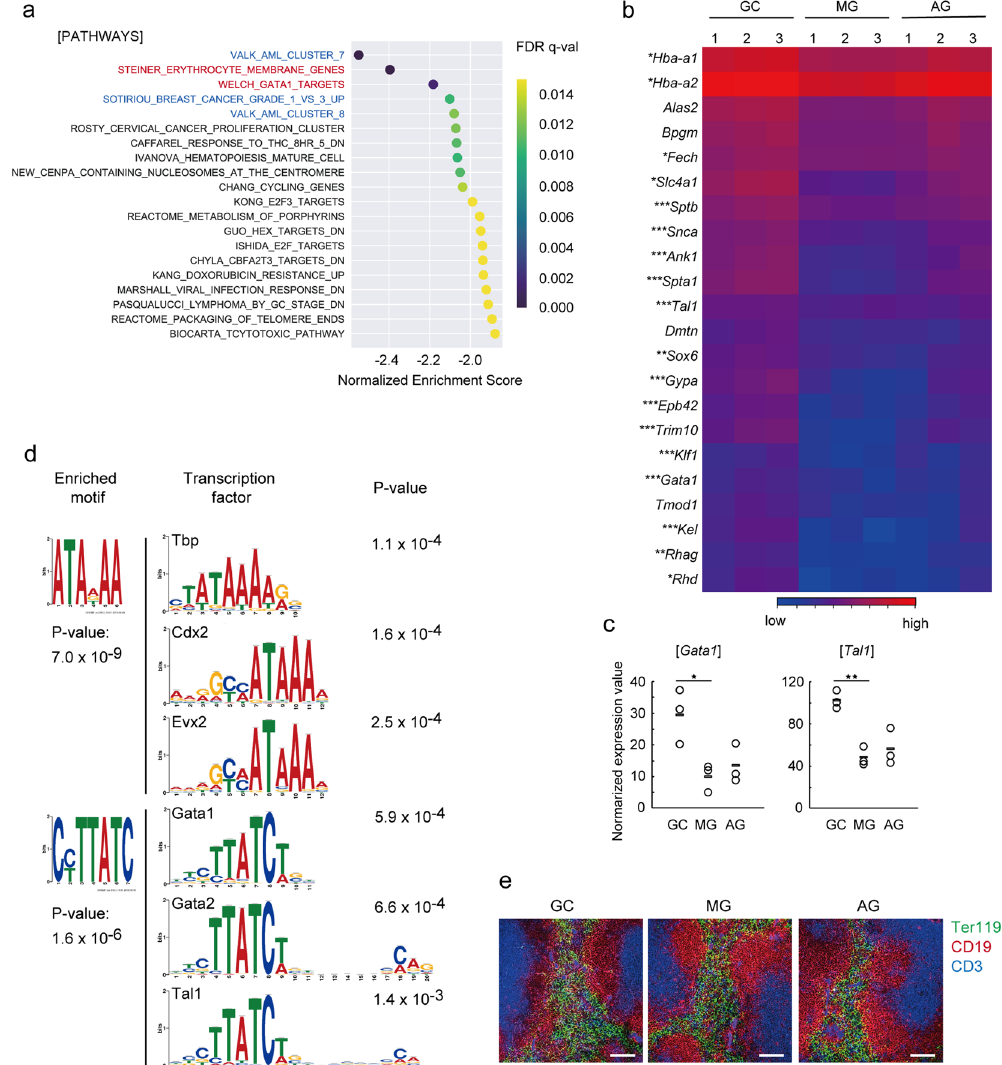
Figure 3. Down-regulation of GATA1 and Tal1-dependent genes in the spleen by spaceflight. ( a ) Gene set enrichment analysis (GSEA) of genes down-regulated in the spleens of MG compared to GC mice. Normalized enrichment score of each term is plotted. Dot colour indicates FDR q-value of enrichment. Erythrocyte- related pathway and GATA-1-related pathway are coloured red. Tumour-related pathways are coloured blue. ( b ) Heat map of representative gene expression in the spleens of GC, MG, and AG mice. Significantly up- and down-regulated genes are indicated as red and blue dots, respectively. * GATA1 target gene, ** Tal1 target gene, *** GATA1 and Tal1 target gene as determined using ChIP-Atlas. ( c ) Normalized gene expression of Gata1 and Tal1 transcripts in the spleen. Bar indicates the average value. ** P < 0.01, * P < 0.05, by EDGE test. ( d ) In silico prediction of transcription factors that bind to a region around to transcription start site (TSS) of genes down- regulated in the spleens of MG compared to GC mice. Enriched motifs (left) indicate genome sequence motifs significantly enriched in the TSS region ( − 200 bp to + 100 bp) of the gene list down-regulated by MG compared with GC. The sequence motifs and P-values were determined using the DREAM algorithm. Subsequently, transcription factors that are predicted to bind to each enriched motif were determined using the TOMTOM algorithm. Names (upper left) and consensus binding sequence of transcription factors are indicated. P-values were determined by TOMTOM algorithm. ( e ) Immunostaining of spleen sections with TER119 (green), CD19 (red), and CD3e (blue). Scale bars indicate 100 µ m. Data represent a typical example of three independent mouse